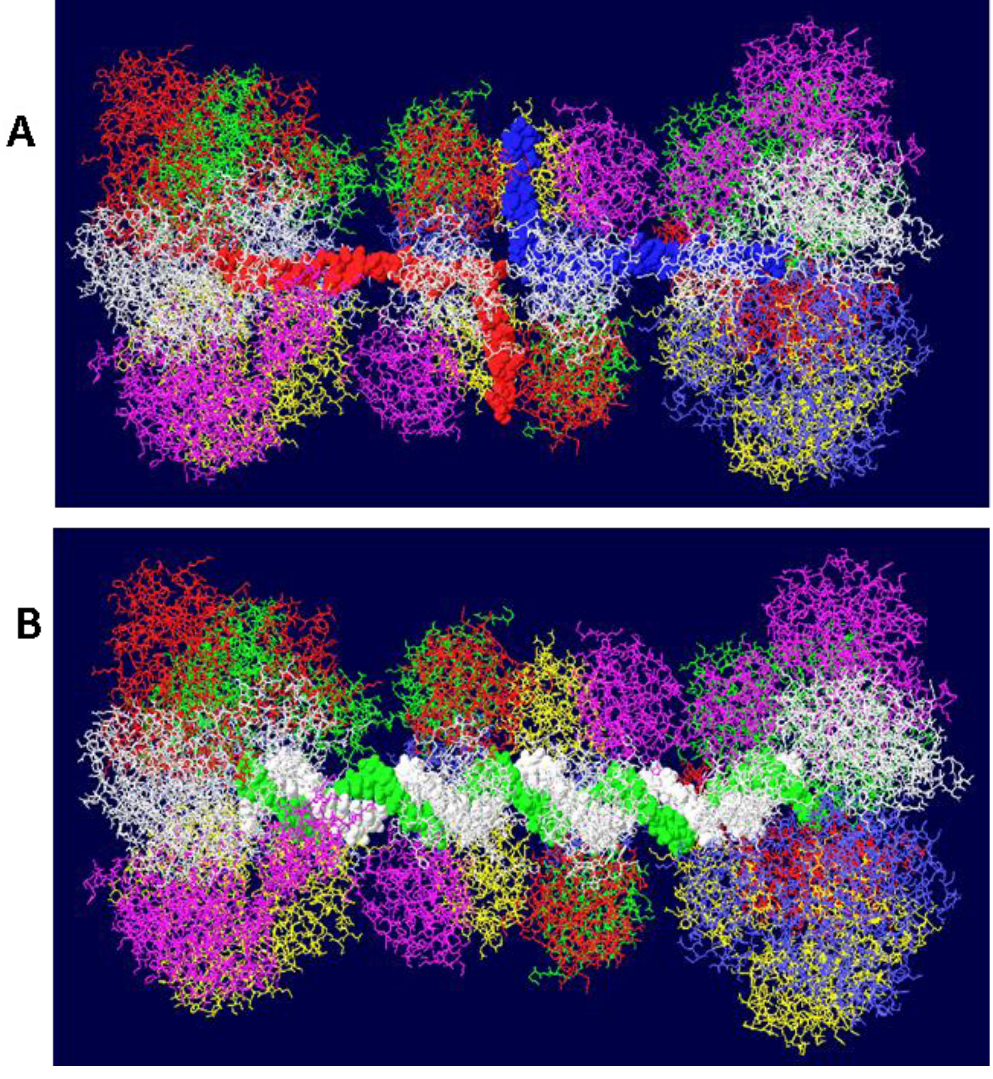
Figure 4. Views of DHs with single and double stranded DNA. Two helicase domains were positioned close to the OBD hexamers to create a model of the T antigen DH viewed from the side. ( A ) Single stranded DNA is shown threading through part of each helicase domain and through the OBD hexamers emerging at the top and bottom. ( B ) Double stranded DNA occupying the central channel of the DH. Only the first helicase subdomains (the small tiers) are filled with DNA. The large tier helicase domains are at the ends of the